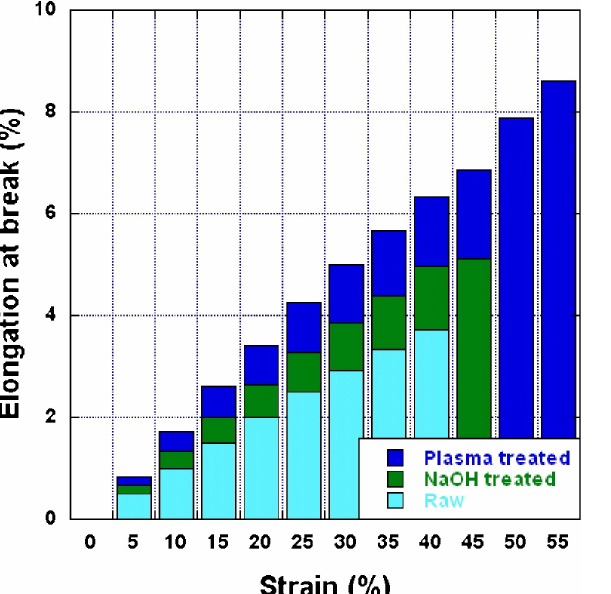
Figure 15: Comparison of elongation at break between untreated and NaOH and plasma treated RH [62]